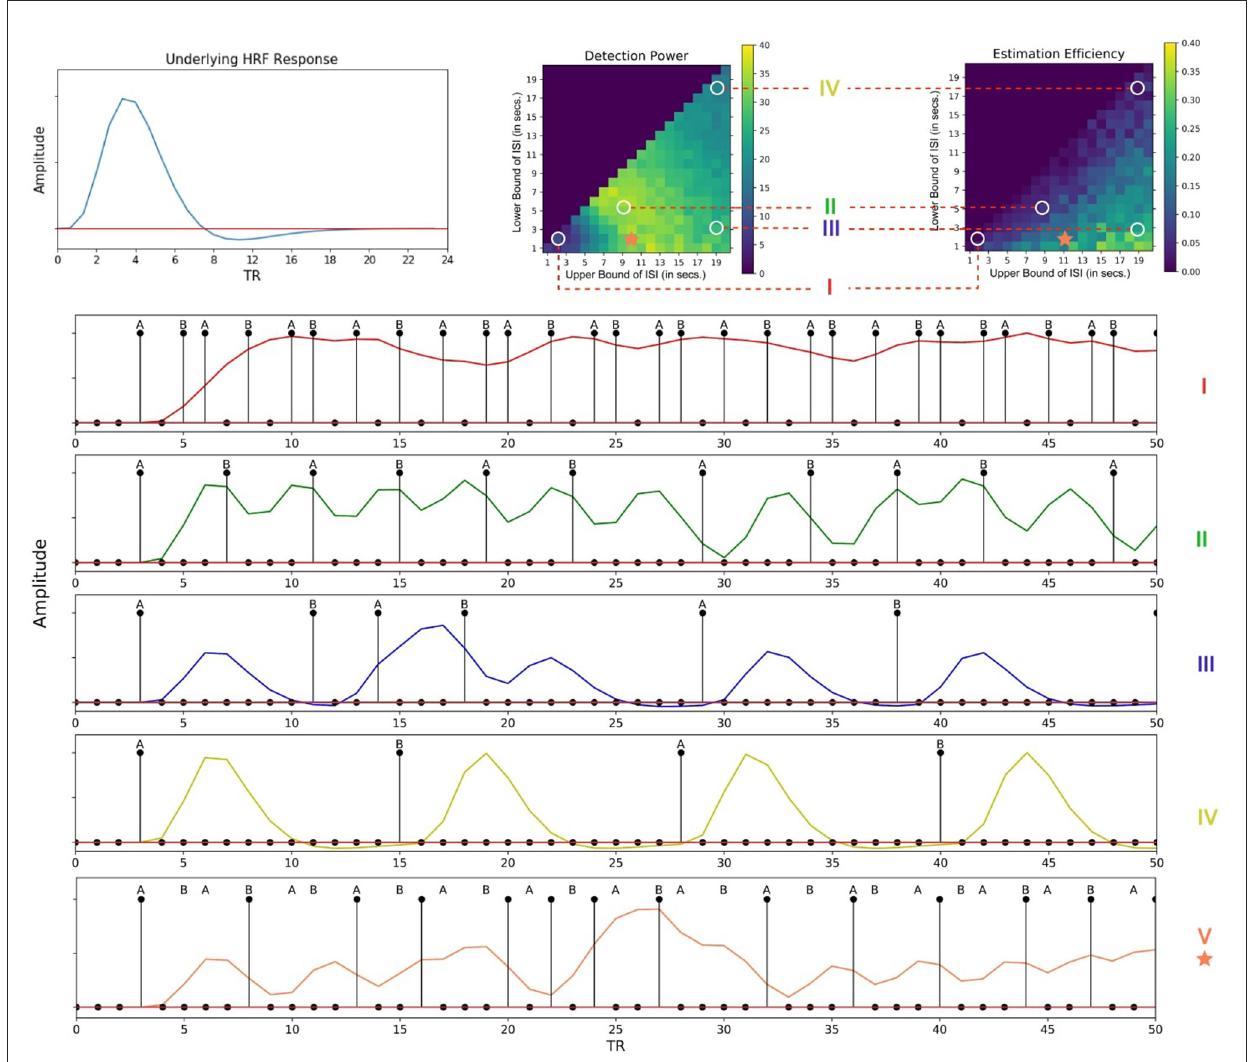
FIGURE9 Individual time courses of hemodynamic responses corresponding to different regions of the fitness landscapes. (Top Left) Underlying hemodynamic response function of the time courses. (Top Right) Different regions of the fitness landscapes. (Bottom) Corresponding time courses; (I)- [ L ISI ∼ 2, U ISI ∼ 3], (II)- [ L ISI ∼ 5, U ISI ∼ 9], (III)- [ L ISI ∼ 2, U ISI ∼ 19], (IV)- [ L ISI ∼ 18, U ISI ∼ 19]; Region V [ L ISI ∼ 2, U ISI ∼ 10], denoted by an asterisk would be ideal for experiments optimized for both detection power and estimation efficiency. (Note: These time courses have been simulated without any noise to better display the details of the individual responses). This figure has been updated for better readability and to fix annotation